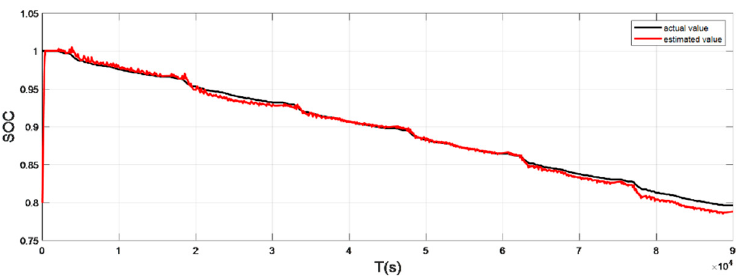
Figure 17. The SOC estimation error under constant current discharge (high temperature: 50 °C).